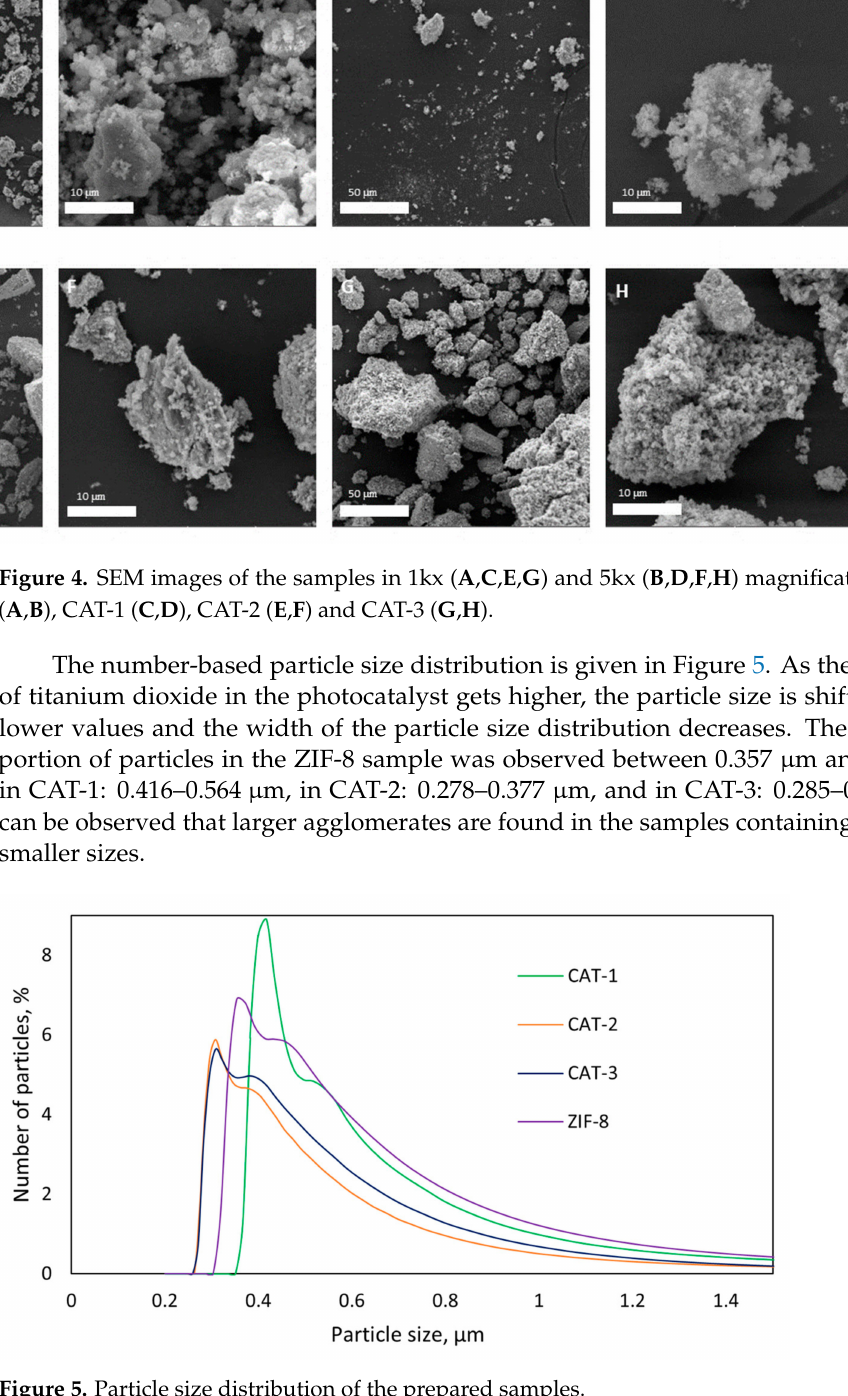
Figure 5. Particle size distribution of the prepared